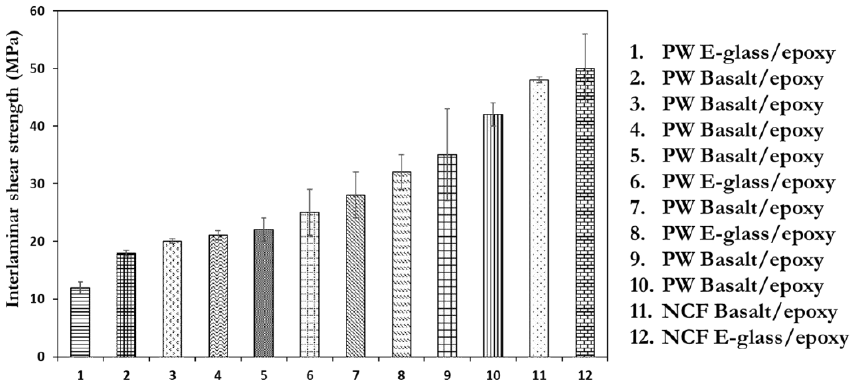
Figure 4. A comparison of interlaminar shear strength of Basalt/epoxy composite against composites